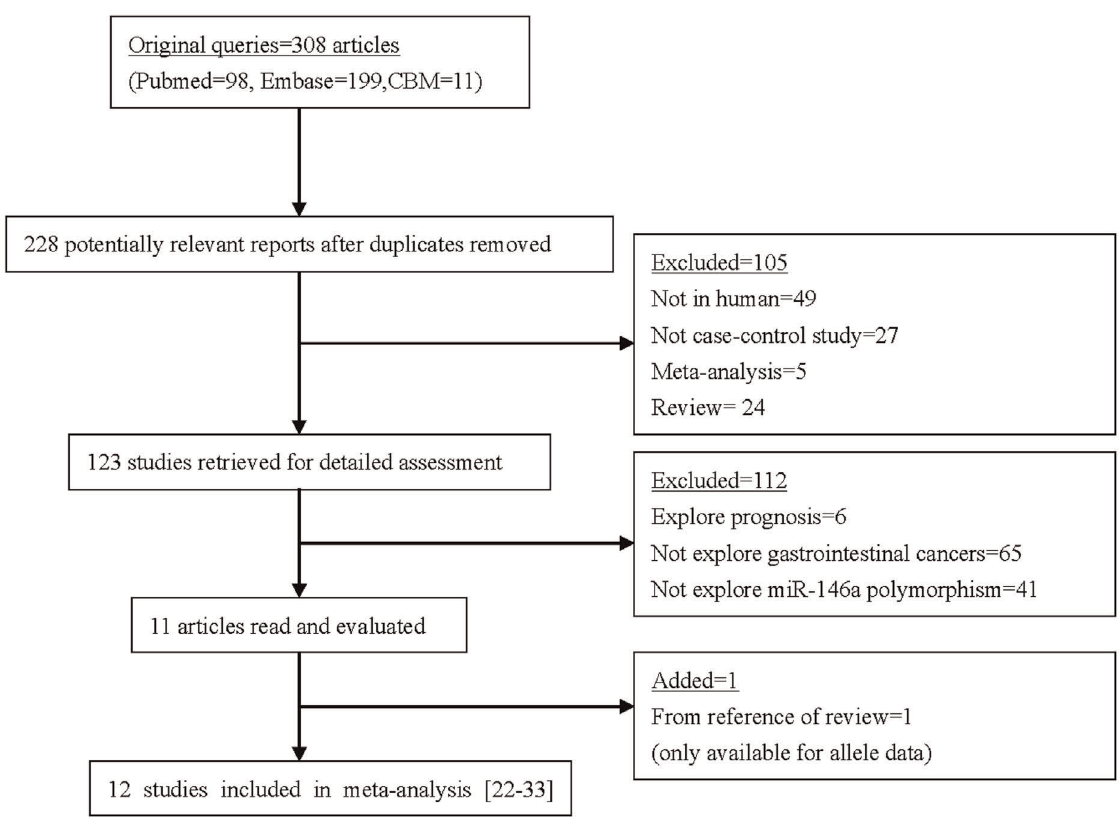
Figure 1. The flow chart of the included studies in the meta-analysis.